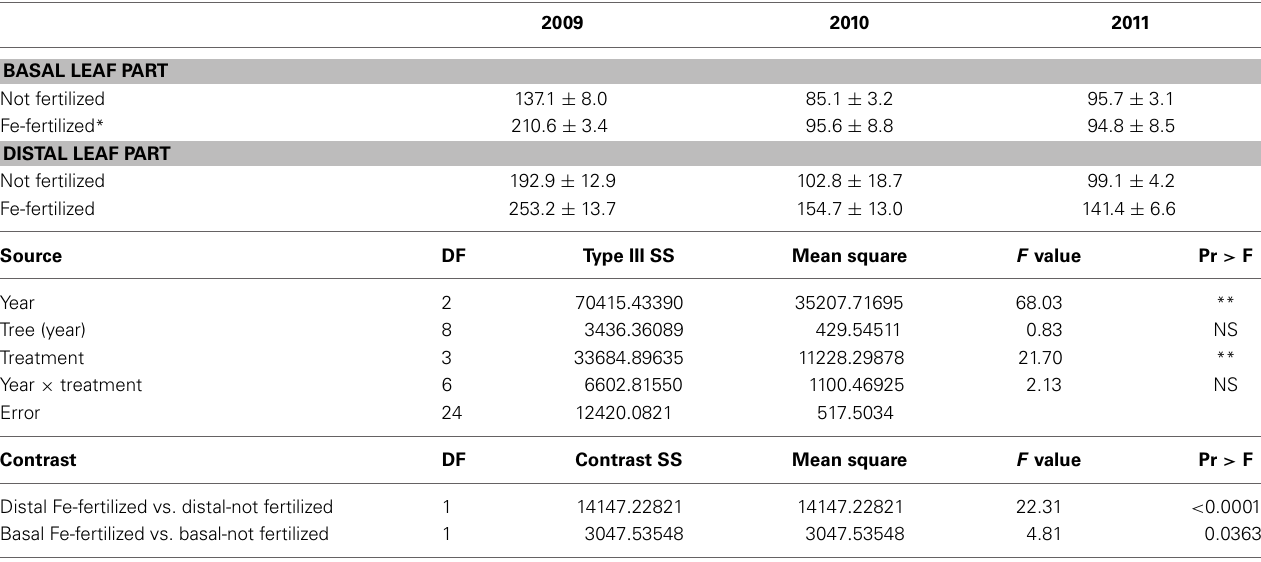
Table A1 | Statistical analysis using “years” as a fixed factor with “trees” nested into years of the same Fe data used in Table 1.